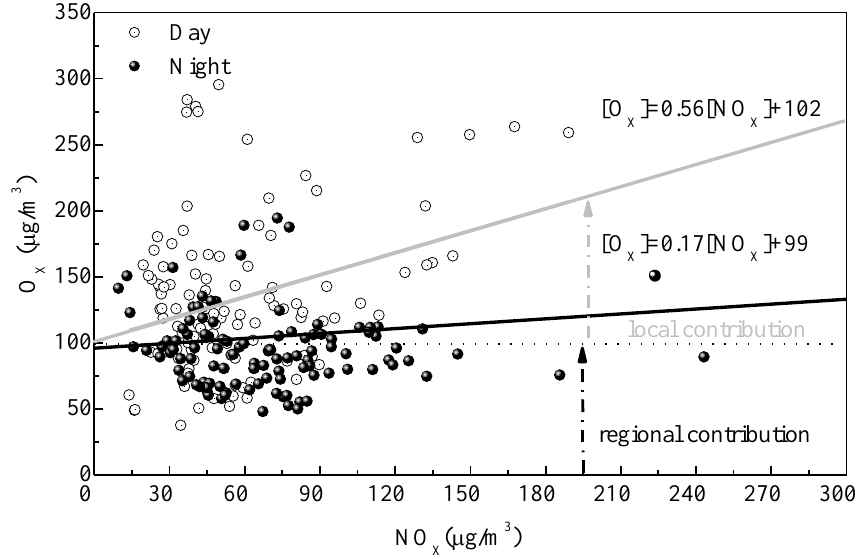
with level of NO X